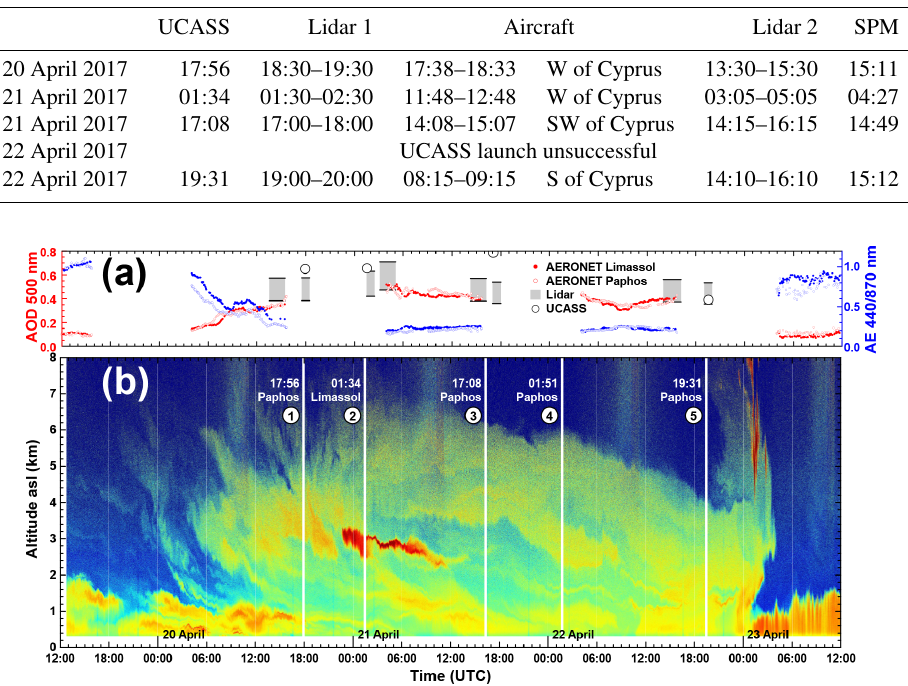
Figure 1. Overview of the aerosol conditions at Limassol (34.7 ◦ N, 33.0 ◦ E) during the 4d period from 20 to 23 April 2017 in terms of (a) the aerosol optical depth (AOD) at 500nm (red) and the Ångström exponent (AE) for the wavelength pair 440 / 870nm (blue) as obtained from AERONET sun photometer observations at Limassol (filled dots) and Paphos (open dots), UCASS (532nm, black circles), and Polly XT lidar measurements (grey bar spanning the range of values obtained from multiplying the 532nm backscatter coefficient with 40 and 60sr). (b) The range-corrected signal at 1064nm as measured with the Polly lidar. Lines and numbers mark the times and locations of UCASS launches. Low backscatter signal (low aerosol concentrations) is shown in blue while very high backscatter signal (dense aerosol layers) is shown in